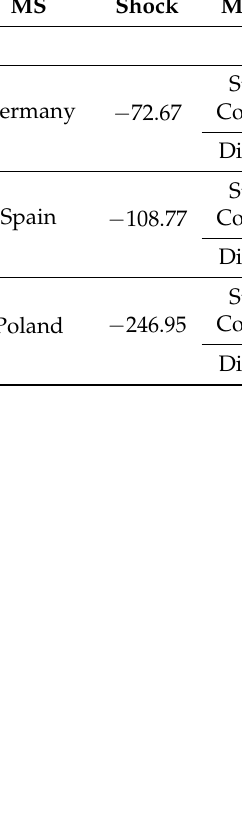
Table 3. Economic impact of FLW reduction by FSS (millions of euros, percentage, number of jobs). MS Shock